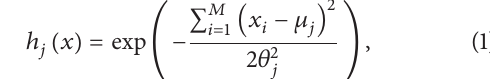
𝑗 is a training vector and 𝑤 𝑆 1 2